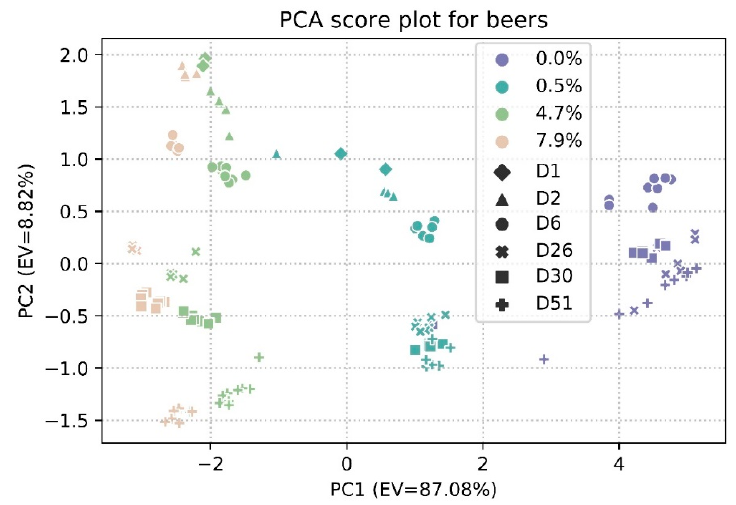
Figure 4. PCA score plot for beer samples. Total explained variance (EV) equal to 95.9% from the first two principal components (PC1 EV = 87.08%, PC2 EV = 8.82%). Colors indicate the different ABV of the samples, markers denote different days (from 1 to 51).